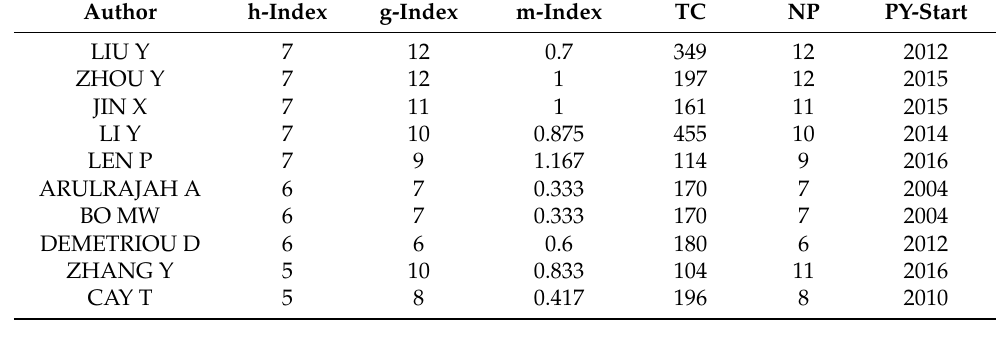
Table 3. Top 10 influential authors in the field of land consolidation.